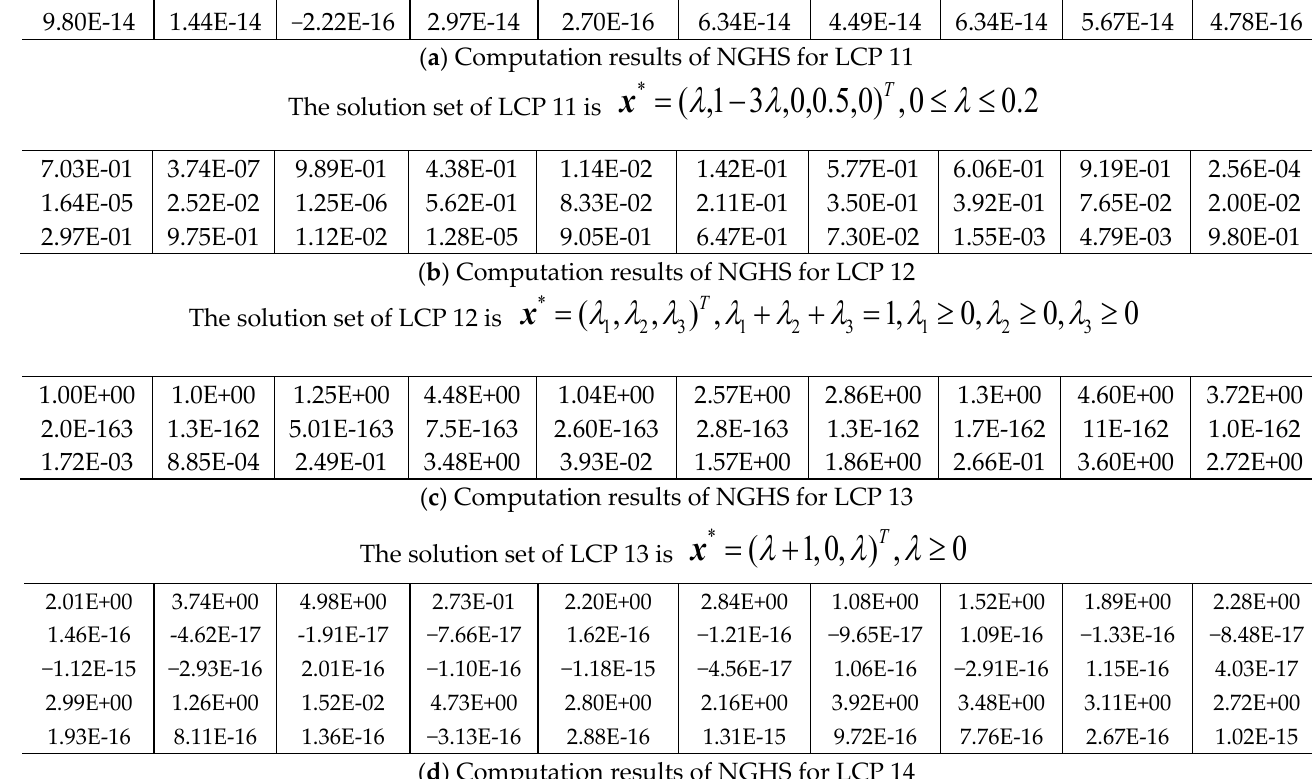
Figure 4. Computation results of NGHS (10 independent runs) for LCP 11~LCP 14.